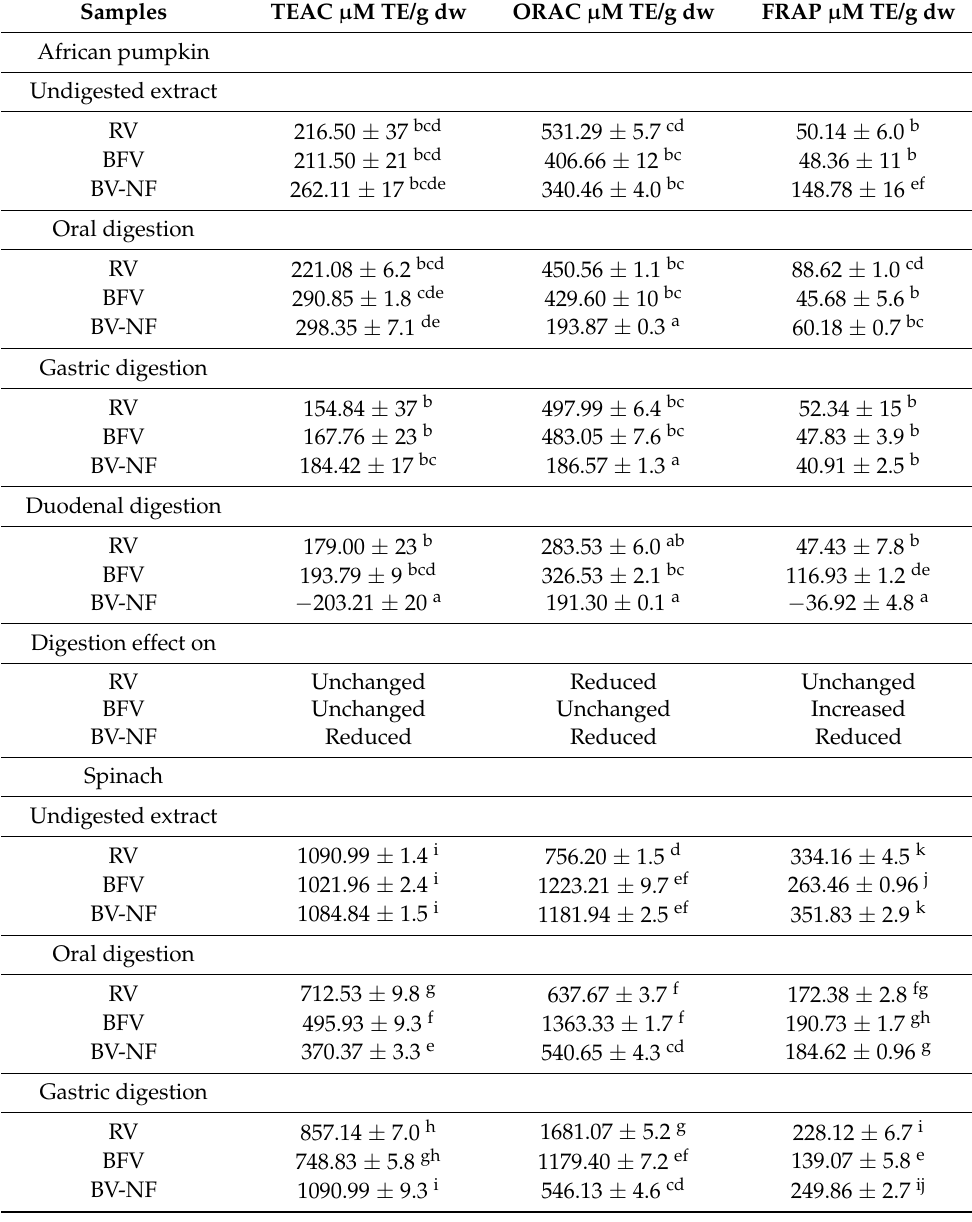
Table 3. Radical scavenging activity/redox potential of African pumpkin and